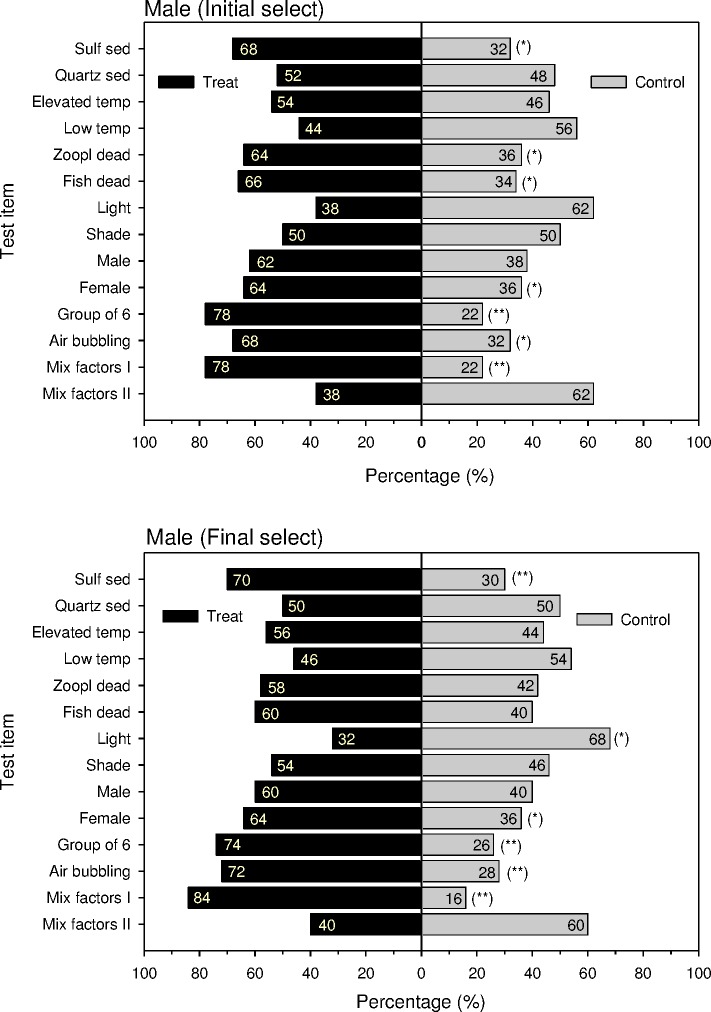
Binary choice of naive male Xenograpsus testudinatus in a binary-choice test tank.Response of initial selection and final selection. Numbers represent the percentage of selection behavior. * is p < 0.05; ** is p < 0.01; *** is p < 0.001.